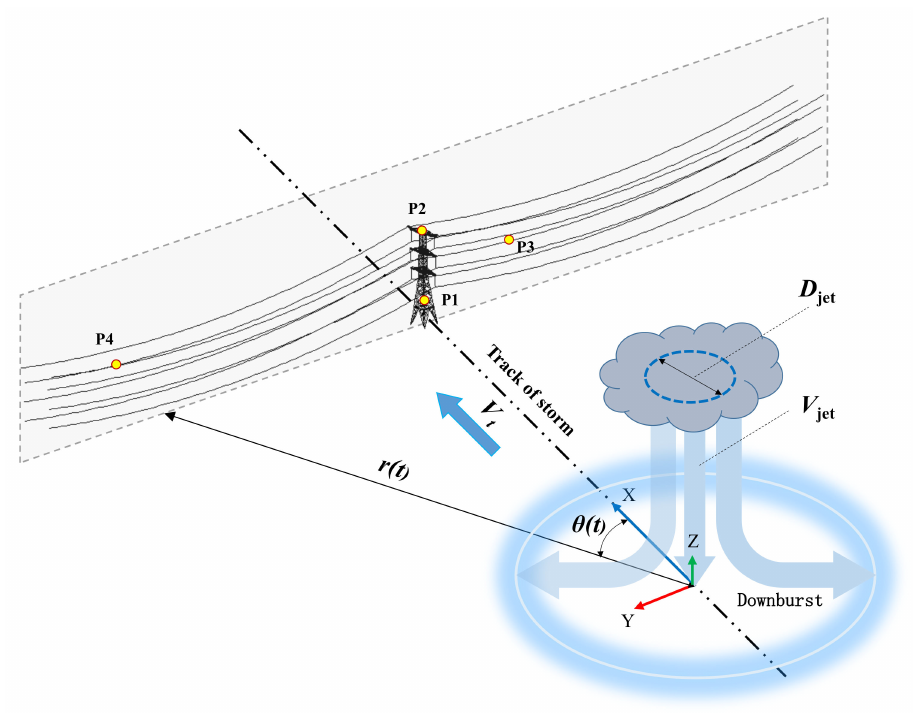
Figure 5. Schematic of relative position relationship between a tower-line system and downburst. (Coordinates Pi = (xi, yi, zi) (m) of the points: P1 = (1200, 0, 31.5), P2 = (1200, 0, 108), P3 = (1200, − 74.6, 31.5), P4 = (1200, 525,